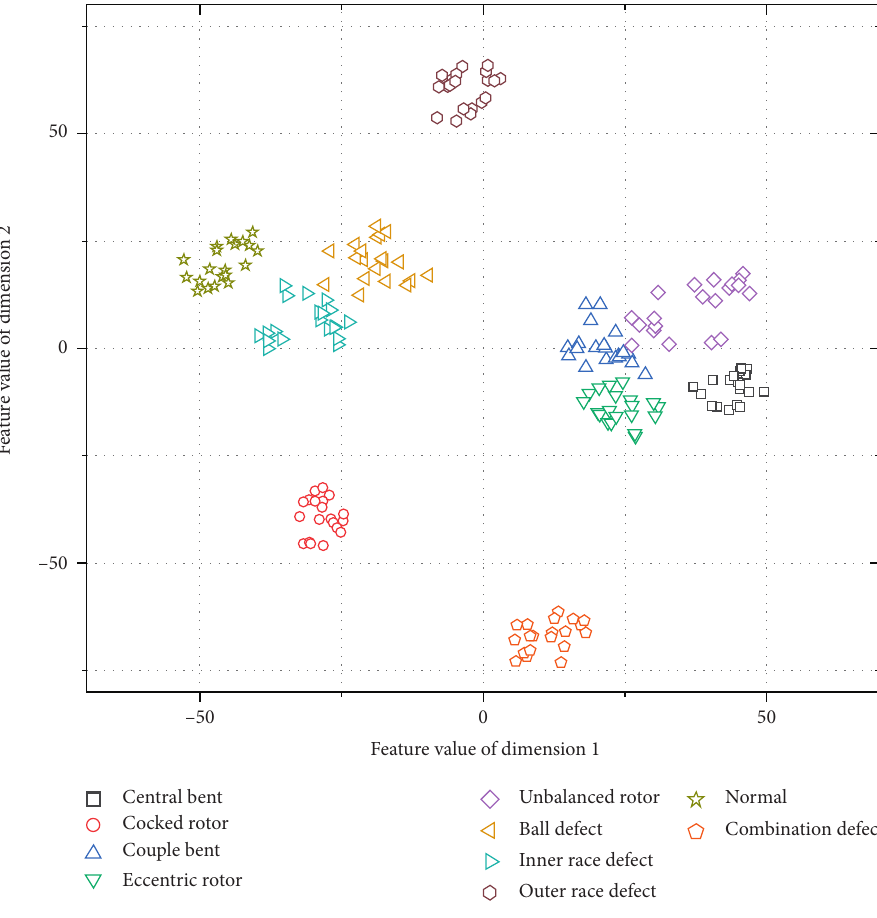
Figure 7: 2D projection of the extracted fault features using t-SNE.